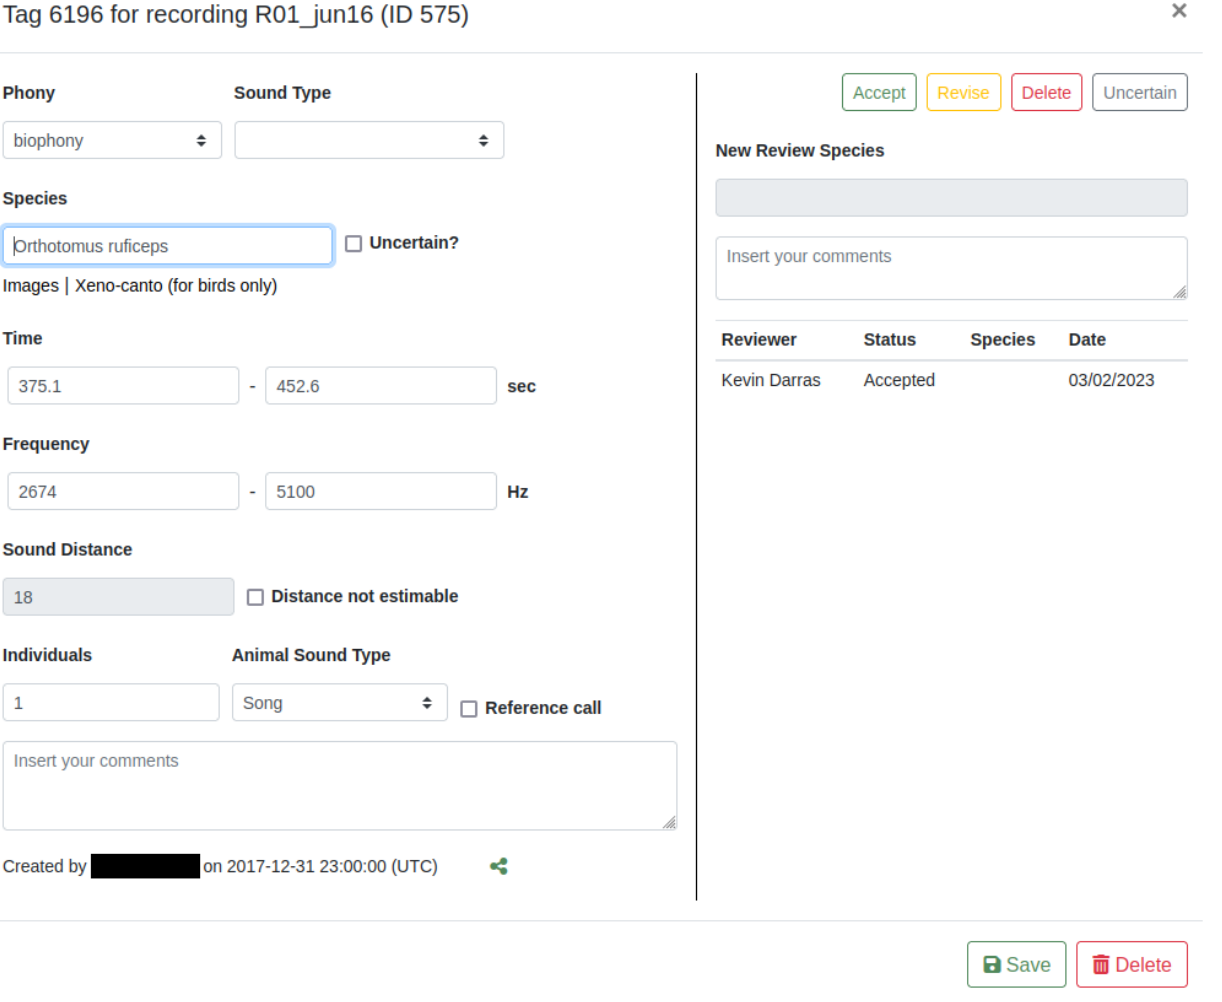
Figure 5. The tag editing window. The phony and sound type selection is remembered for faster tagging. Species, sound distance, individuals, and animal sound type fields are only shown when “biophony” is selected. Sound distance estimation is greyed out because values can only be entered with the dedicated function or declared as not estimable. Green sharing button: copies a URL to the clipboard to open the exact spectrogram region. The entire right pane is only visible to users with reviewing